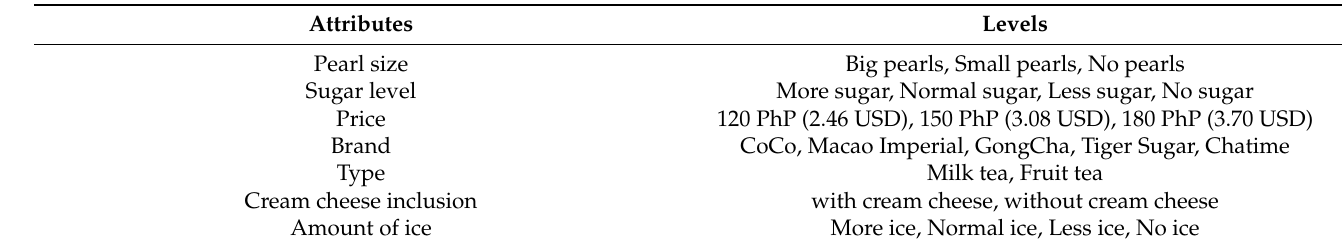
Table 2. Attributes of milk tea in the Philippines.